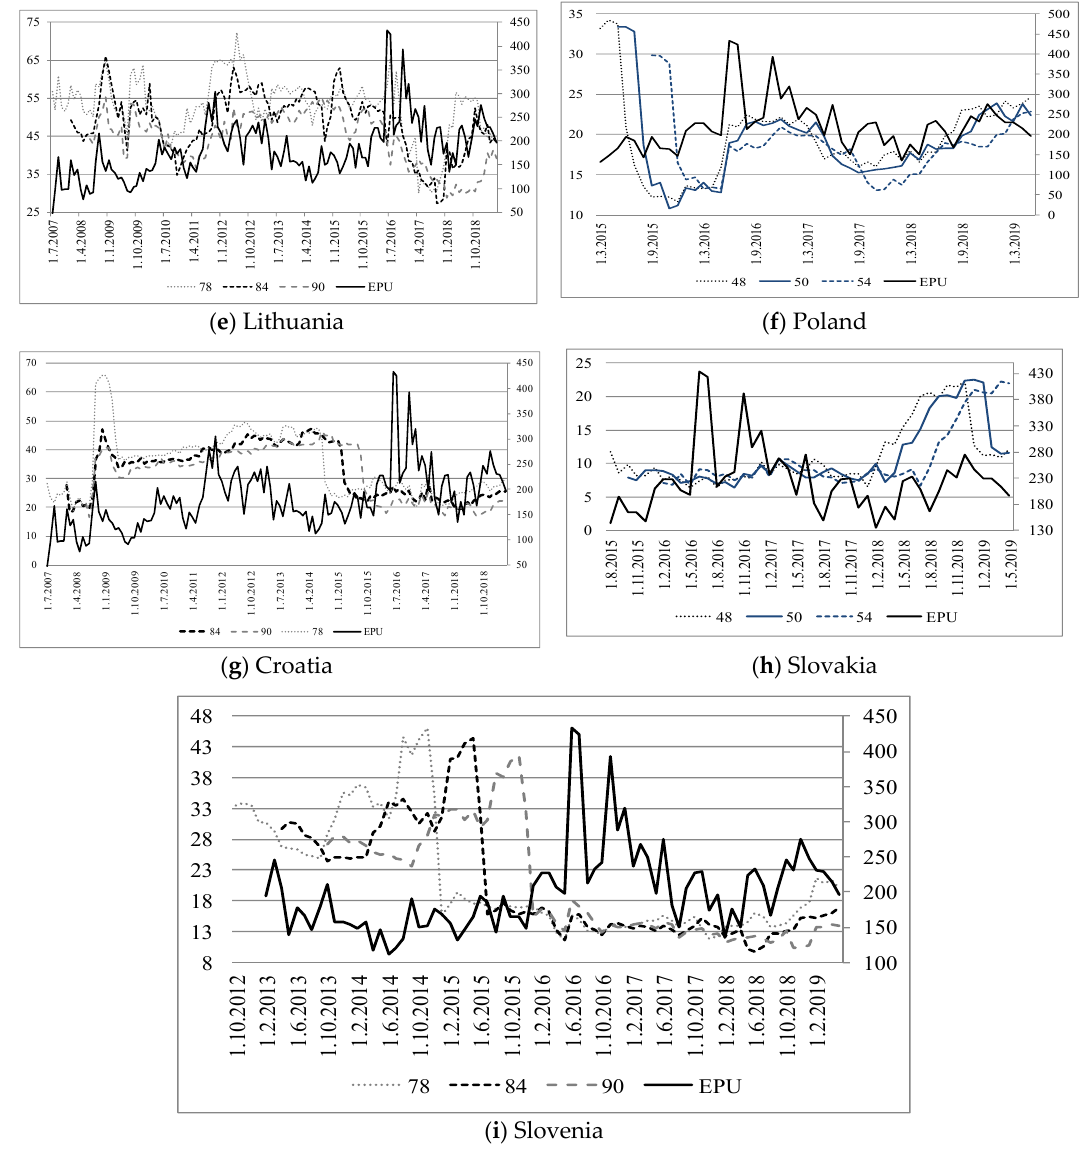
Figure A2. Rolling total spillover indices ( left axis ) for every country compared to EPU ( right axis ).